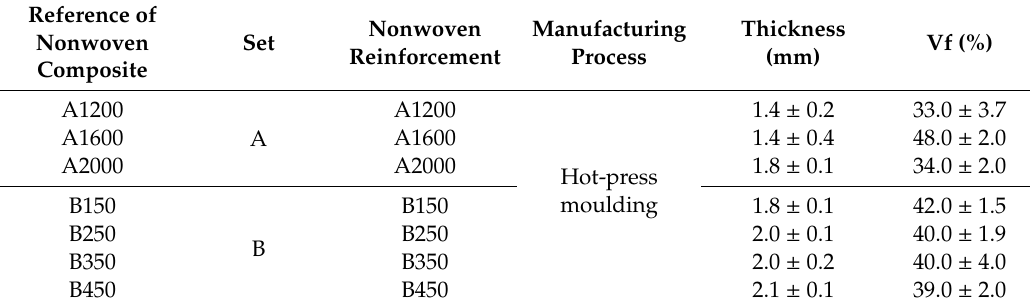
Table 2. The main parameters of the tested nonwoven